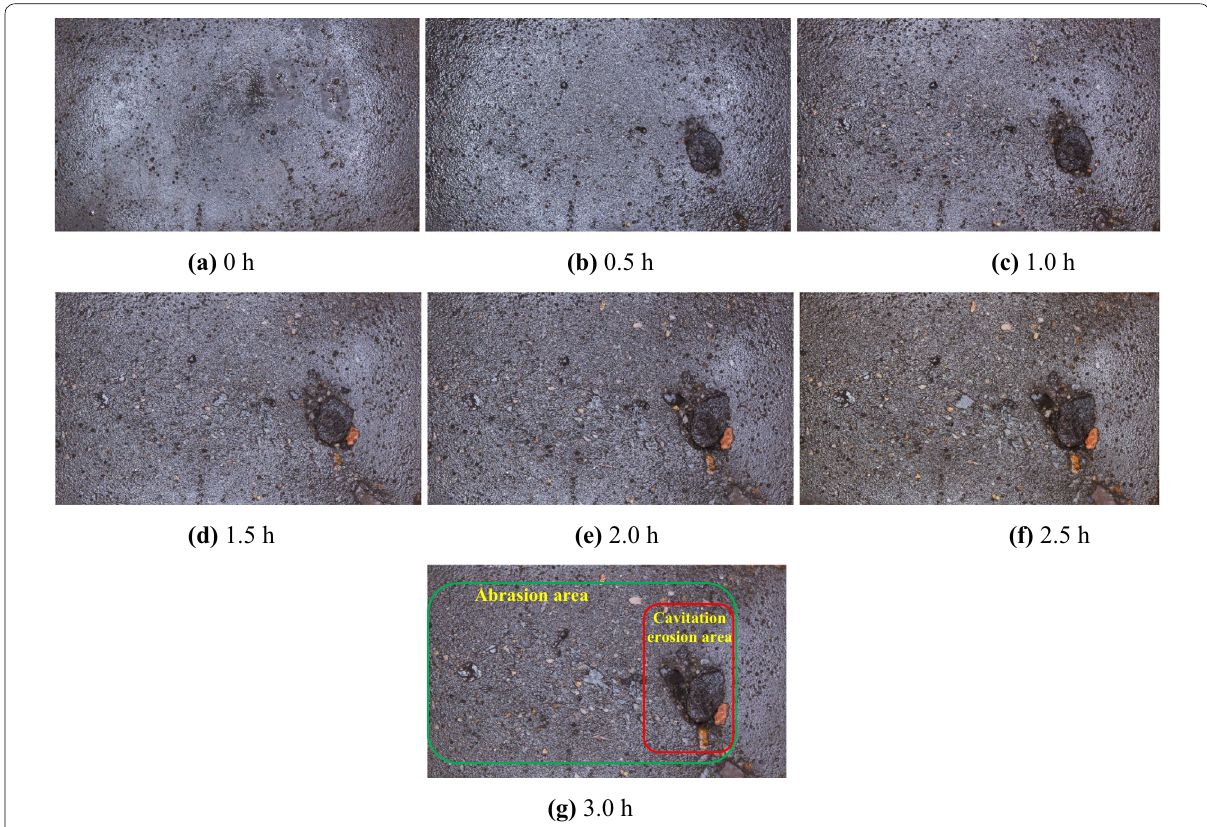
Fig. 7 Concrete wear process under the combined action of cavitation erosion and abrasion.